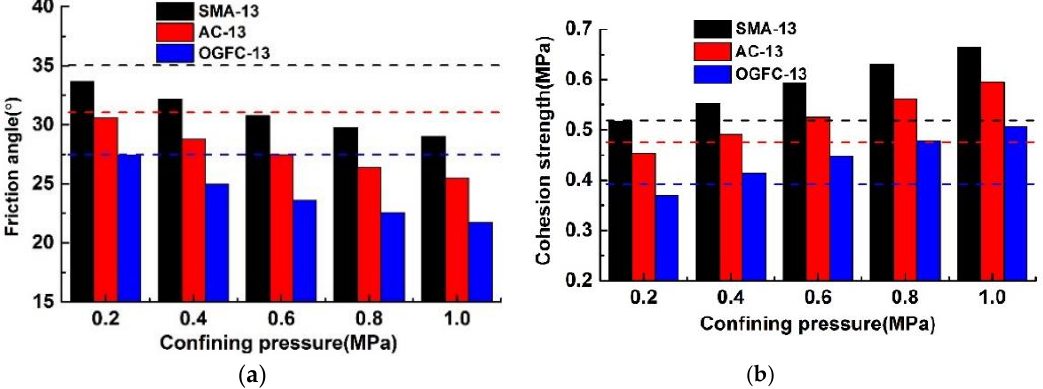
Figure 12. Friction angle and cohesion strength of asphalt mixtures with linear and nonlinear Mohr – Coulomb failure criterions at 40 °C. ( a ) The friction angle of asphalt mixtures with linear and nonlinear Mohr – Coulomb failure criterions at 40 °C; ( b ) The cohesion strength of asphalt mixtures with linear and nonlinear Mohr – Coulomb failure criterions at 40 °C.